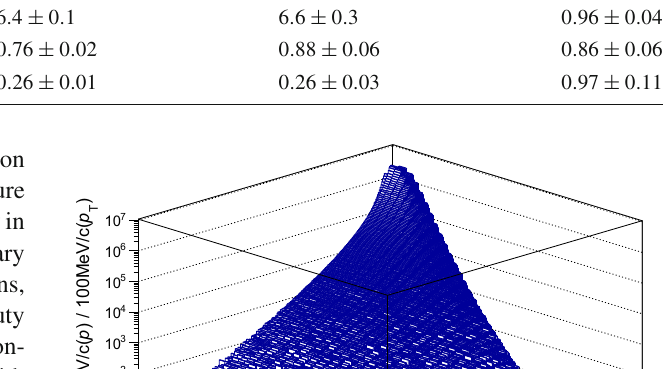
reconstructed tracks in different momentum bins per 10 9 POT per GeV/c for data and simulation. The statistical errors for data are negligible. For data, the uncertainties are dominated by the uncertainty in the POT normalization, 2 . 1%. For the simulation, the main uncertainty is due to a different reconstruction efficiency in the simulation compared to data,